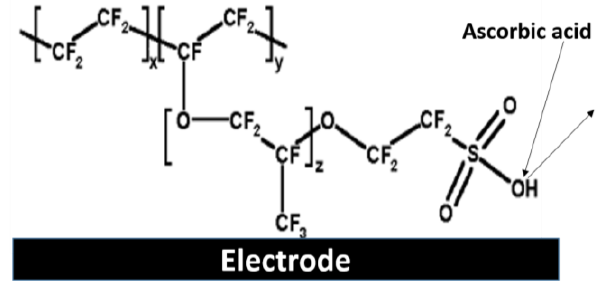
Figure 6. Schematic representation of nafion membrane restricting passage of interfering analyte, ascorbic acid.